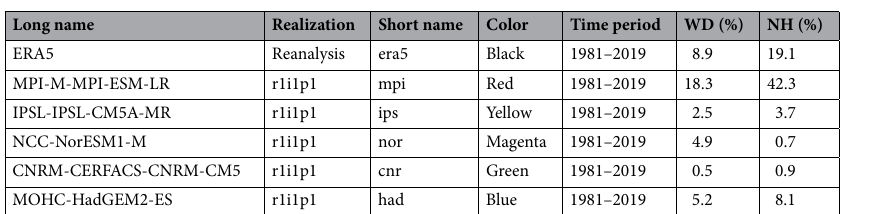
Figure 7. Hovmöller diagrams of positive WPI anomalies (grey contours) averaged over 40–70 Aug 2010 ( a ) and 2018 ( b ). Overlaid are temporal evolution of longitudinal conditions of heat (red), wetness (purple) and drought (orange). The map (on top) shows longitudinal stripes of the total precipitation anomalies with regard to 1981–2010: purple (wet) and brown (dry). The reference period for all anomalies is 1981–2010 and the value ranges of the contours are given in the lower left boxes, respectively. The maps were created by using python3-mpltoolkits.basemap (version 1.2.1, https:// matpl otlib. org/ basem ap/).